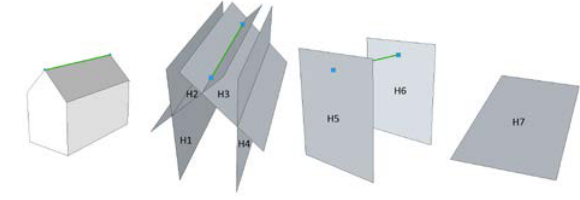
Figure 3. Pitched roof building with a ridge feature (green line), two gable features (blue dots), and corresponding half-spaces.